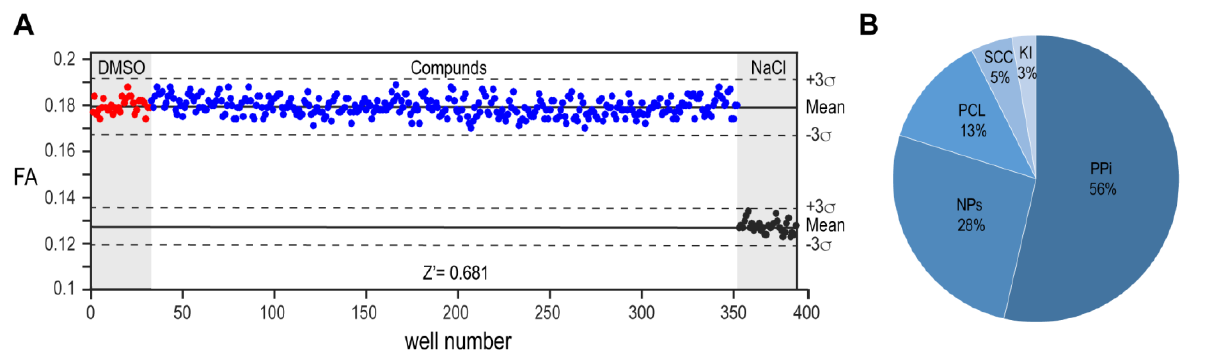
FIGURE 4: High-throughput screening of compound library. (A) Evaluation and visualization of fluorescence anisotropy data from the high- throughput screening of 10,100 compounds. The screening is performed on 384-well plates where the first and the last two columns are used for negative controls reported in red (0.1% DMSO; no drug added) and positive controls reported in black (900 mM NaCl). The areas used for positive and negative controls are highlighted in light grey. The middle columns (320 wells) are used to test compounds (10 μM compound final concentration, final DMSO concentration 0.1%) and reported in blue. The library was processed in duplicate on 64 plates. The Z’-factor determination for plate validation is calculated using the fluorescence anisotropy signals of the controls and com- pounds wells. The solid lines represent the mean fluorescence anisotropy value for controls and compounds measurements, the dashed lines denote the average ± 3 standard deviation of the negative and the positive controls, respectively. In this example, a Z’-factor of 0.681 is suitable to validate the plate. (B) Pie chart of 10,100 compounds from BSF-ACCESS Chemical Collection. Five different classes of com- pounds are screened: PPi (Protein-Protein interaction, 5’411 compounds), NPs (Natural Products, 2’654 compounds), PCL (The Prestwick Chemical Library, 1’280 compounds), SCC (Swiss Chemical Collection, 474 compounds) and Kinase Inhibitors, 275 compounds. The relative percentage of each class of compounds over the entire screened library is